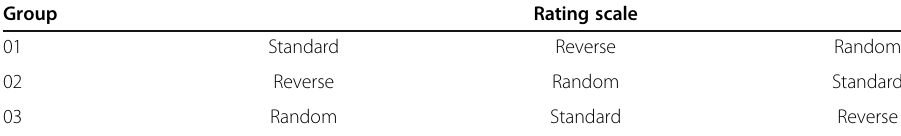
Table 2 Rating scale order for novice